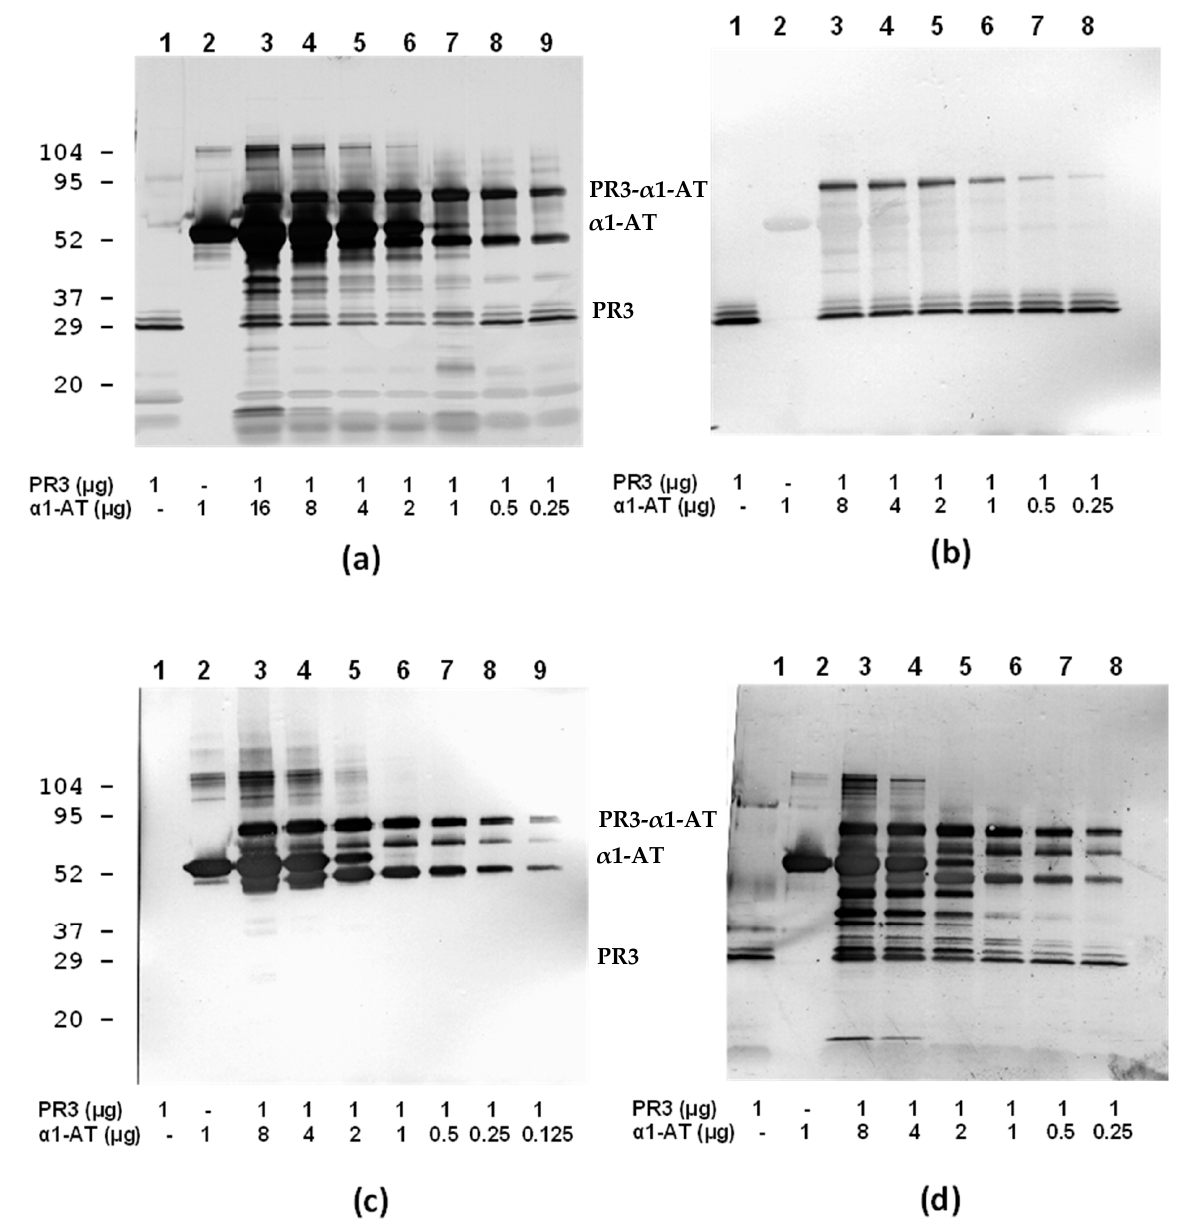
Figure 8. SDS-PAGE and immunoblotting analysis of PR3 (Wieslab) and α 1-antitrypsin interactions. ( a ) Silver staining of PR3- α 1-antitrypsin complexes at varying amounts. ( b ) Individual and complex staining using HYB 172-05. ( c ) Individual and complex staining using MAb α 1-antitrypsin. ( d ) Individual and complex staining using MAb defensin D1F4.